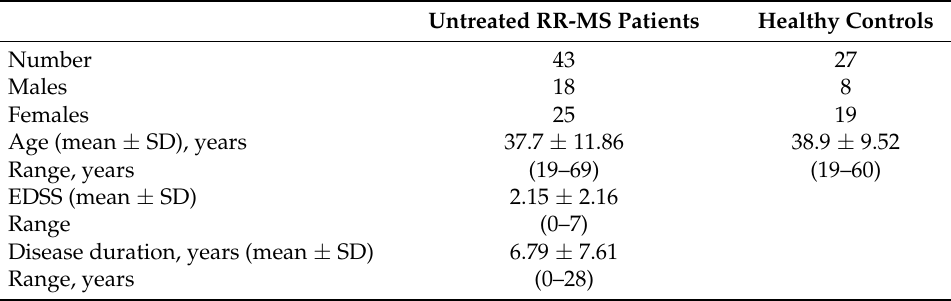
Table 1. Clinical data